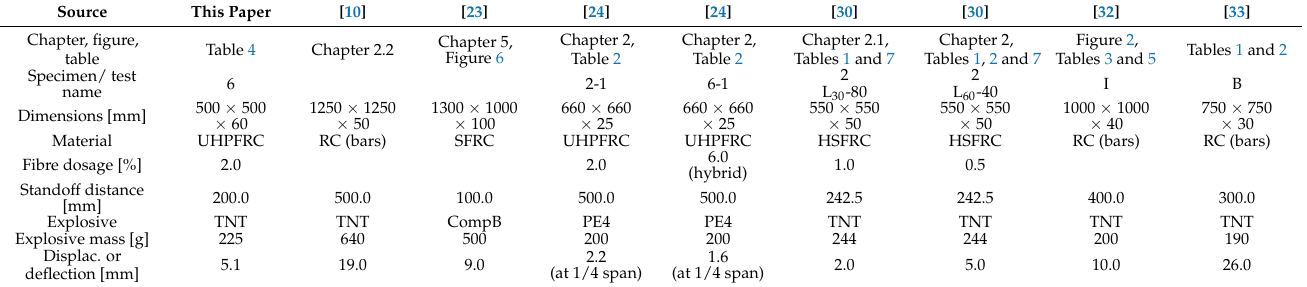
Table 5. Comparison of experimental measured deflection of concrete slabs under explosive load.